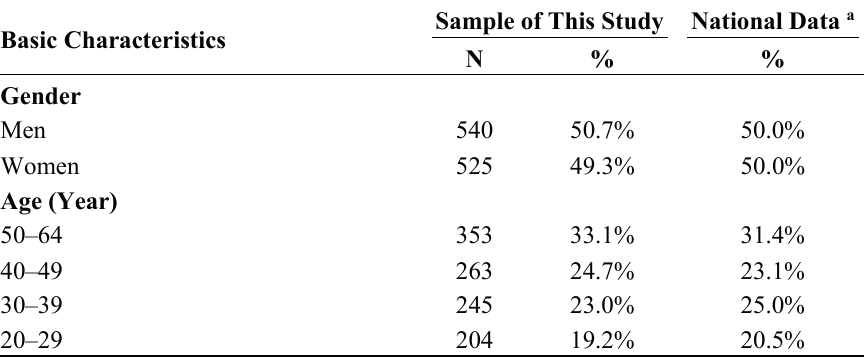
Table 1. Basic characteristics of all respondents ( n =